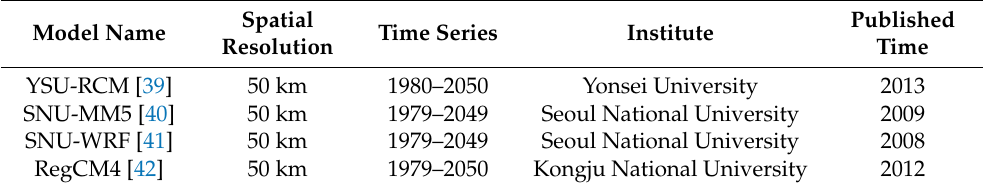
Table 1. The four regional climate models used in this study and their characteristics. Model